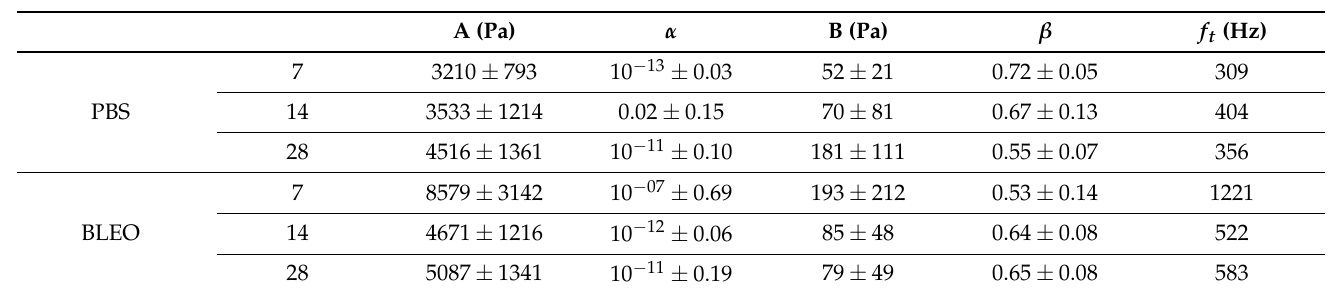
Table 1. Parameters of a two-power law and estimated transition frequency. The parameters were fitted to data acquired for the PBS and bleomycin-instilled lungs at 7, 14, and 28 days after instil- lation. The transition frequency f t was defined as the frequency at which A ( if ) α = B ( if ) β , that is, ) . Values are shown as mean ± SD. f t = exp ( ln ( B ) − ln ( A ) α −− β